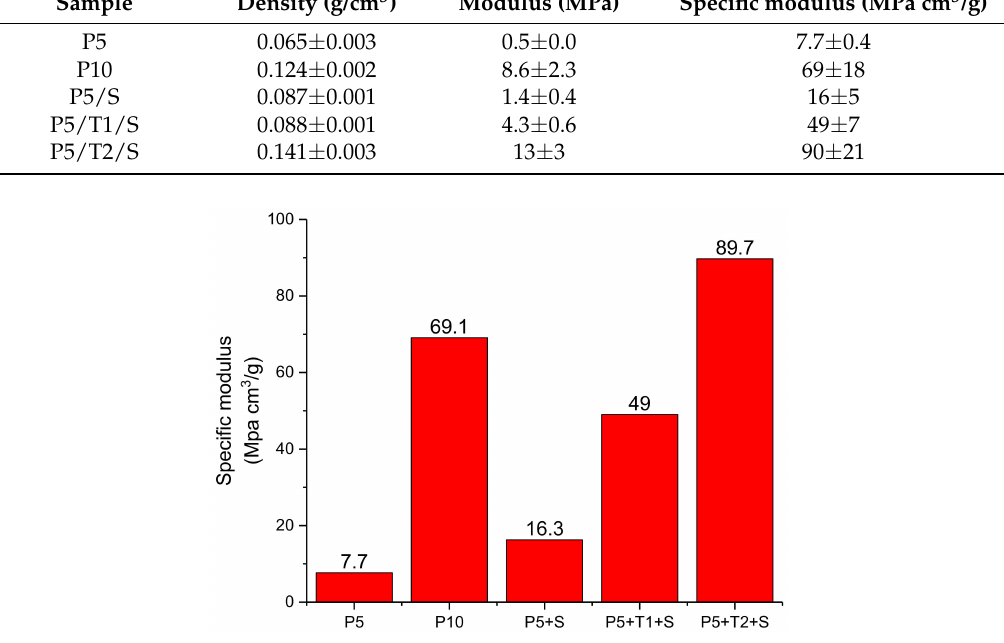
Figure 2. Specific moduli of aerogels with different